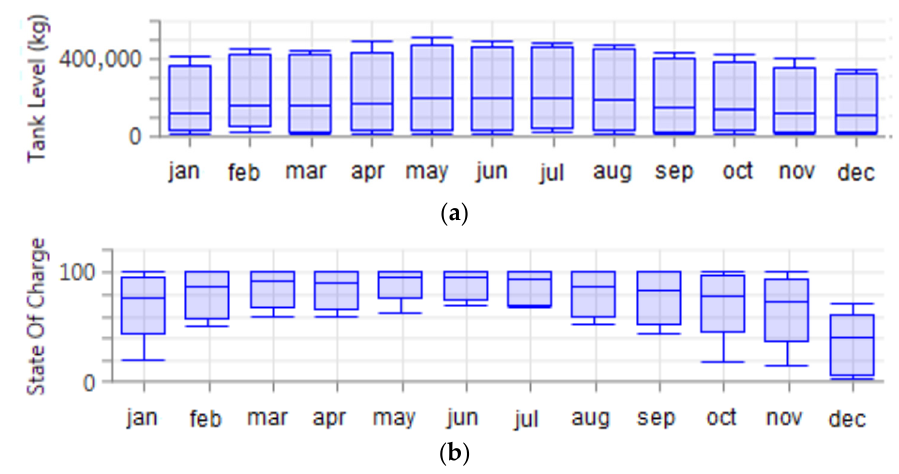
Figure 20. Monthly data of the storage systems. ( a ) Reverse pumping; ( b ) mega-batteries. The hourly representation of typical summer and winter days is displayed in Figure